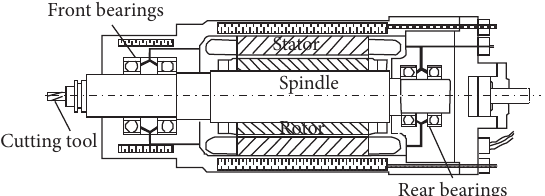
Figure 1: A typical high speed motorized spindle system.